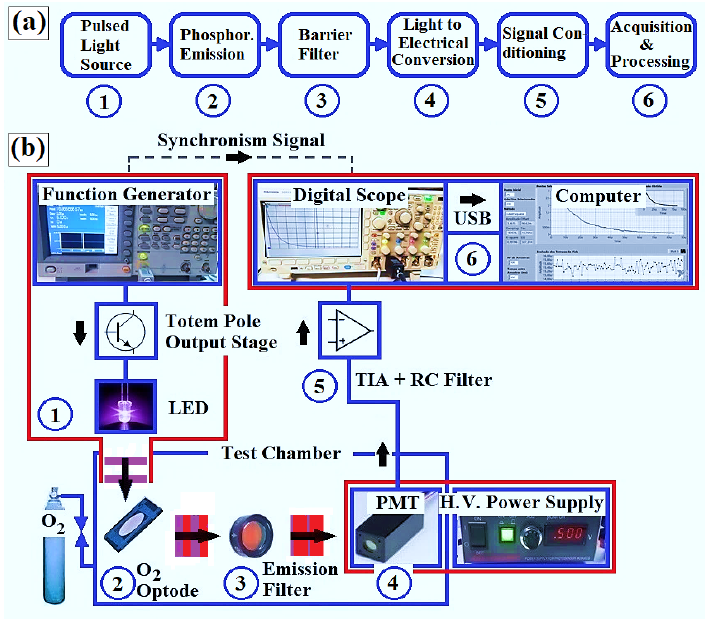
Figure 2. ( a ) Block diagram of the built instrument and ( b ) physical